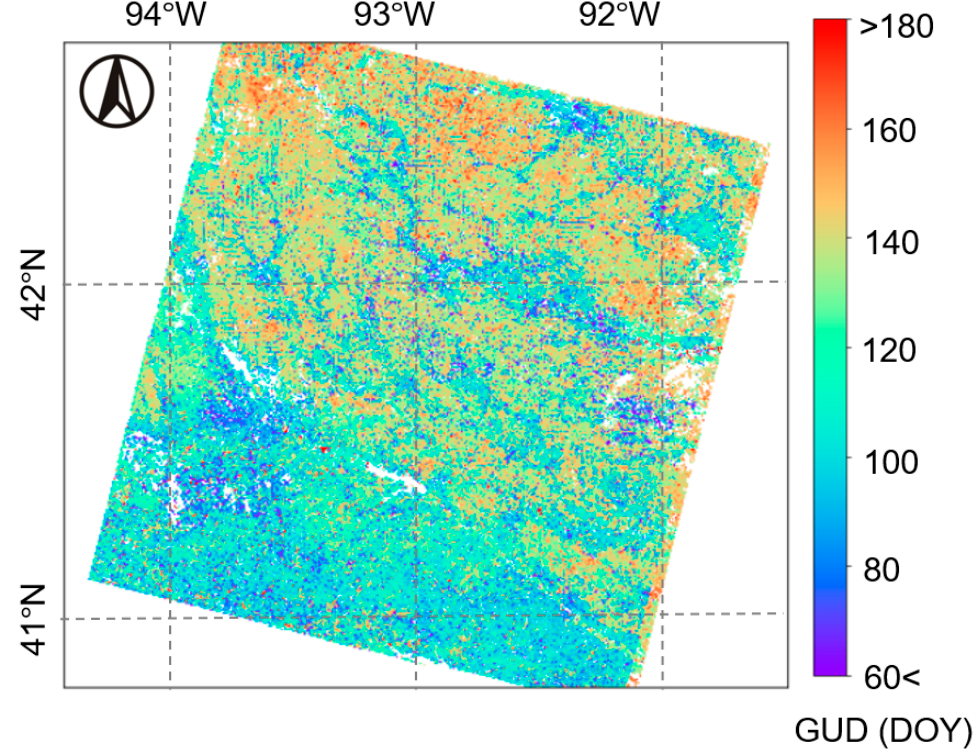
Figure 6. The GUD detected from fine resolution MODIS-Landsat fused EVI2 images.